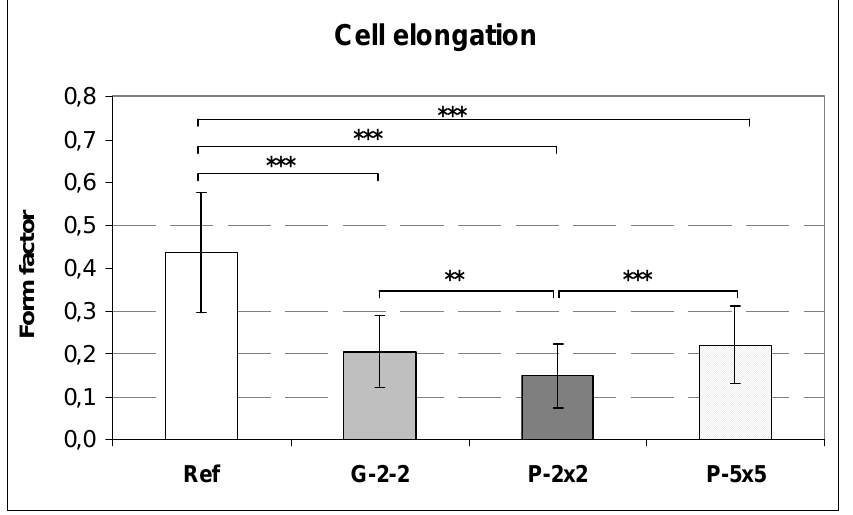
Figure 5. Cell elongation of MG-63 osteoblasts on microtextured titanium surfaces